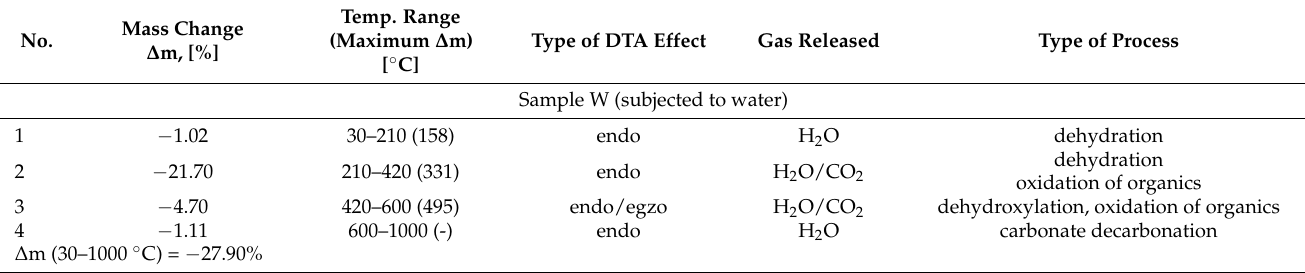
Table 2. Weight changes in C 3 A samples stored under different conditions during heating and associated thermal